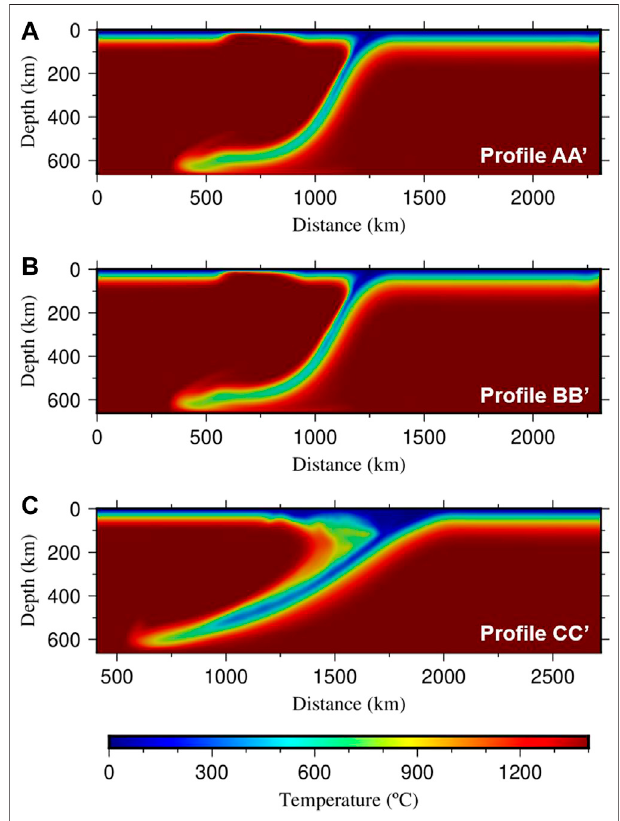
FIGURE 4 | Temperature fi eld along the pro fi les of AA ’ (A) , BB ’ (B) , and CC ’ (C) at 13.25 Myr in the reference model. The locations of the AA ’ , BB ’ , and CC ’ pro fi les are shown in Figure 2A